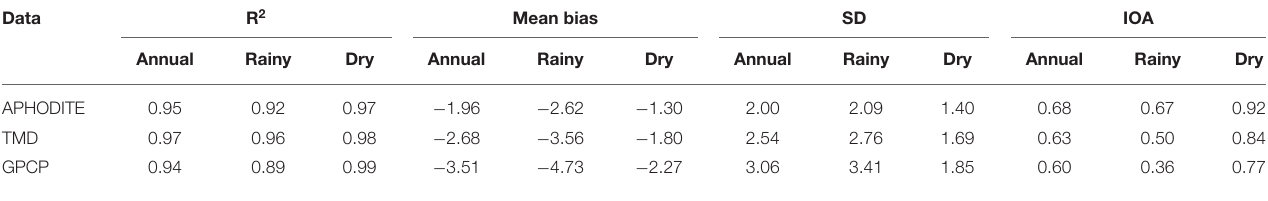
TABLE 1 | Statistics comparing the modeled precipitation and observation [adapted from Amnuaylojaroen and Chanvichit (2019)].